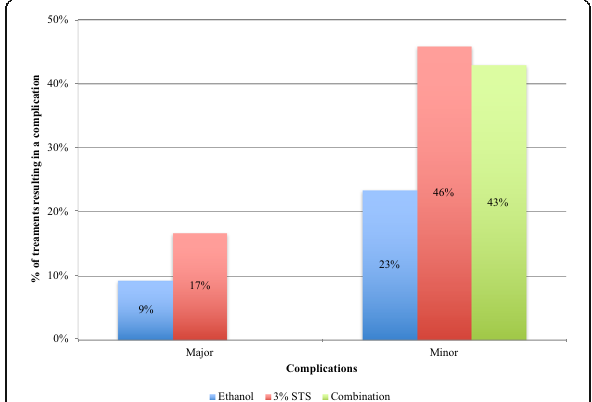
Fig. 2 Major and minor complication rate for each sclerosant. Single treatment with bleomycin